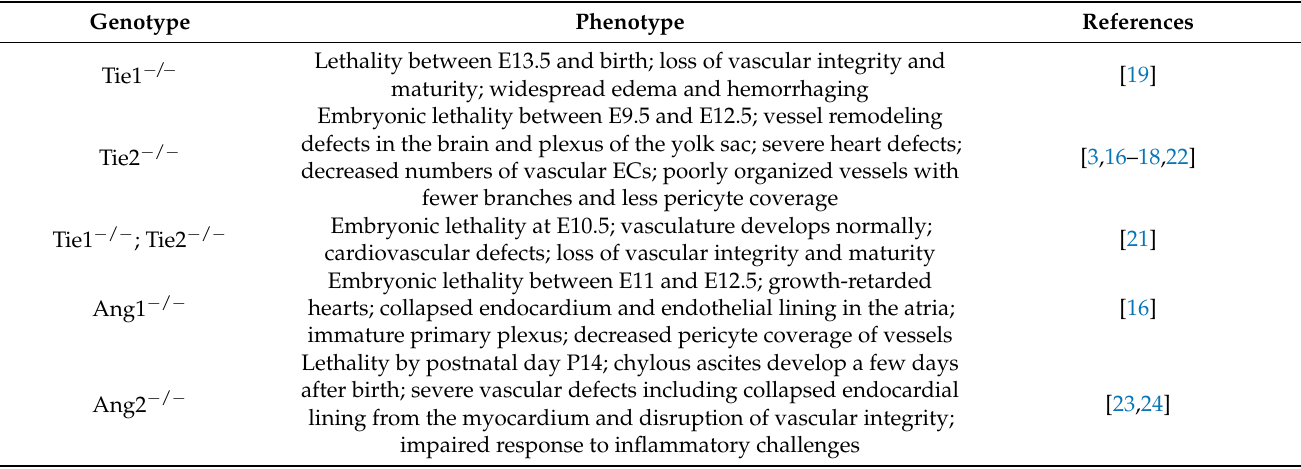
Table 1. Phenotypes of Ang-Tie2 knockout